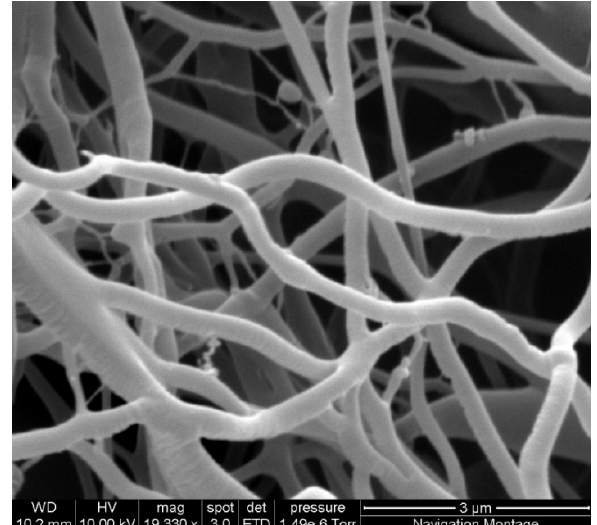
acetate, 1% lithium chloride and 1:1 DMAc: acetone solvent solution. The spinning parameters were 30 kV, 15 cm and 1 µL/min. Notice how the fibres are branched. Areas of precipitation of lithium chloride may be seen on some of the